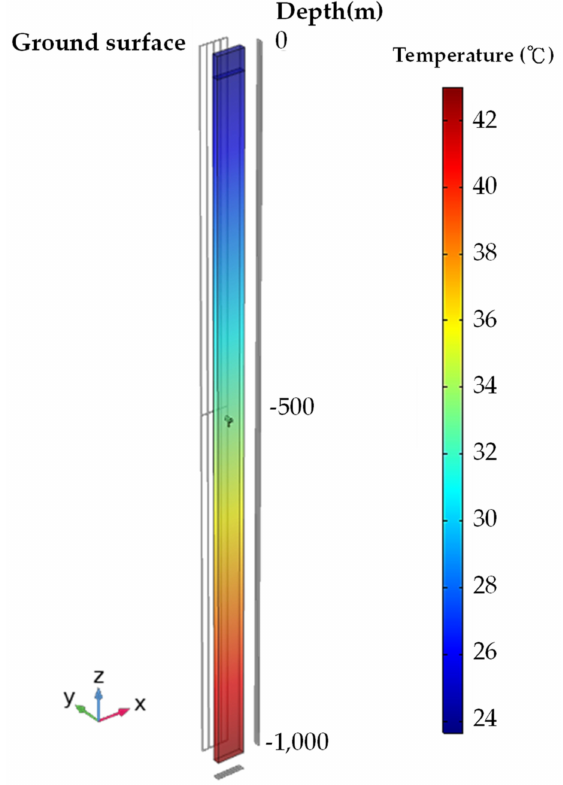
Figure 2. Initial temperature of the reference case in Taiwan.